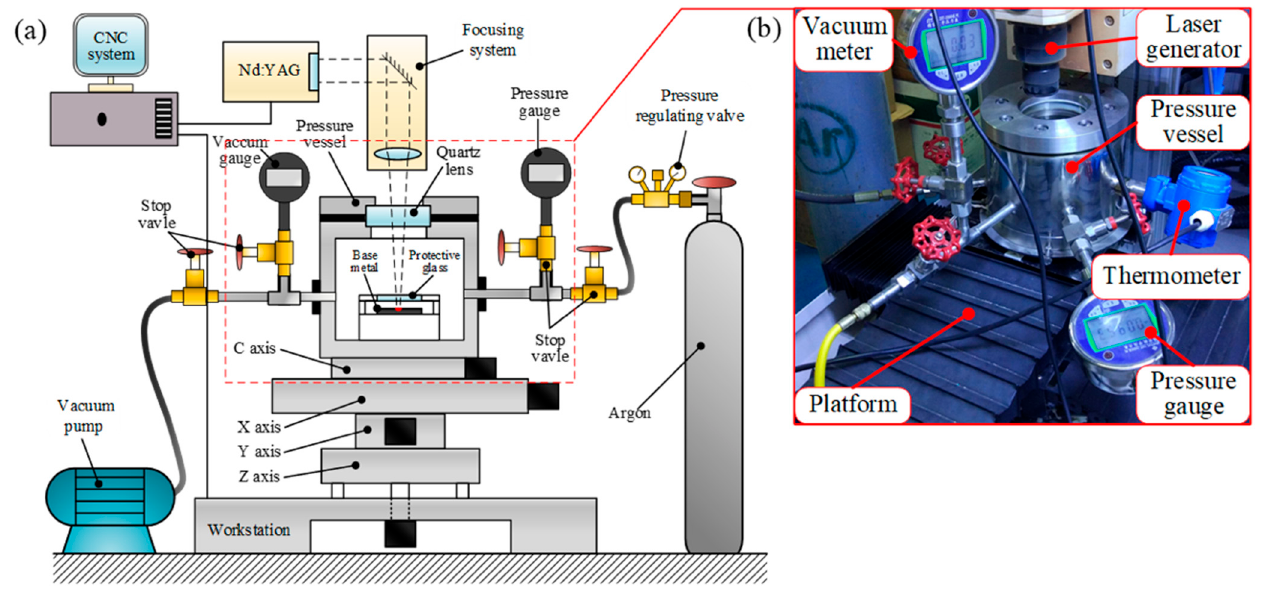
Figure 1. Inert gas positive-pressure vessel experimental device: ( a ) schematic diagram of the experimental setup, ( b ) physical diagram of pressure vessel.